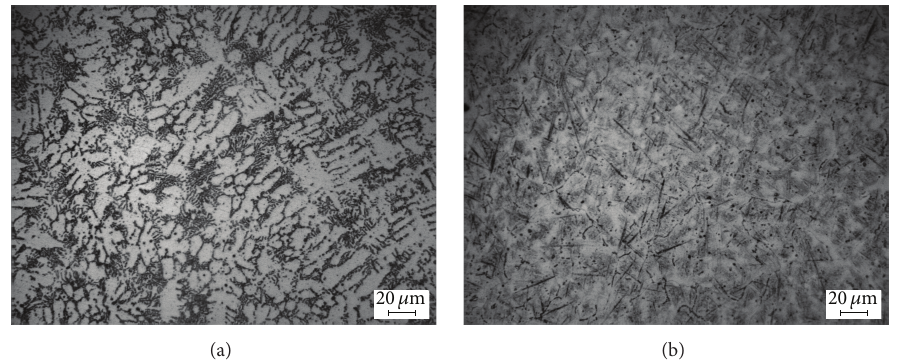
Figure 3: Microstructure of hardfacing layer of (a) alloy 2 and (b) alloy